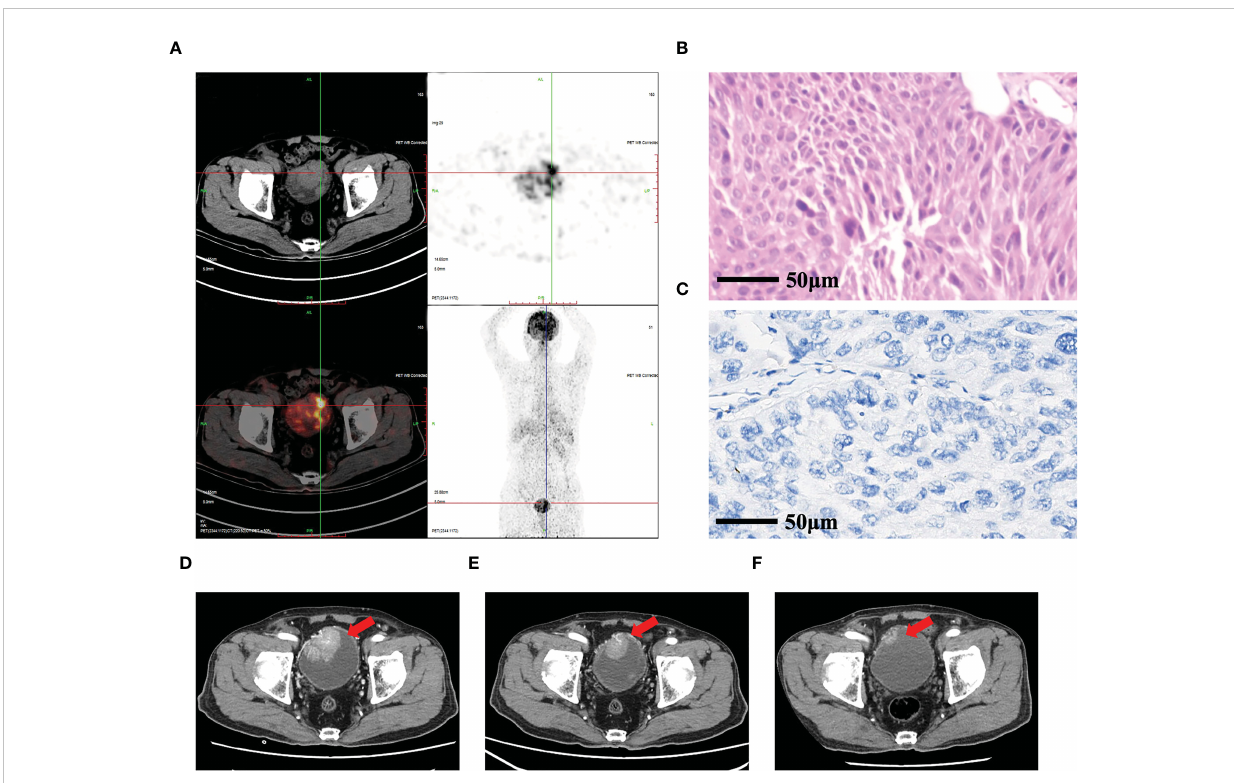
FIGURE 1 Pathological and imaging examination of case 1. (A) Whole-body PET/CT showing bladder thickening, multiple nodular and mass-like soft tissue shadows in the cavity, and increased metabolism. (B) Pathological results of hematoxylin and eosin cytology staining of a tumor biopsy specimen. (C) PD-L1 expression was evaluated by immunohistochemistry. (D) Enhanced CT of the abdomen before treatment showing a 5.3 × 4.0 cm mass in the bladder with signi fi cant enhancement in the arterial phase (red arrow). (E) After two cycles of treatment, enhanced CT of the abdomen revealed that the tumor shrank to 4.1 × 3.2 cm (red arrow). (F) After 14 cycles of treatment, enhanced CT of the abdomen revealed that the size of the tumor was 1.2 × 1.0 cm (red